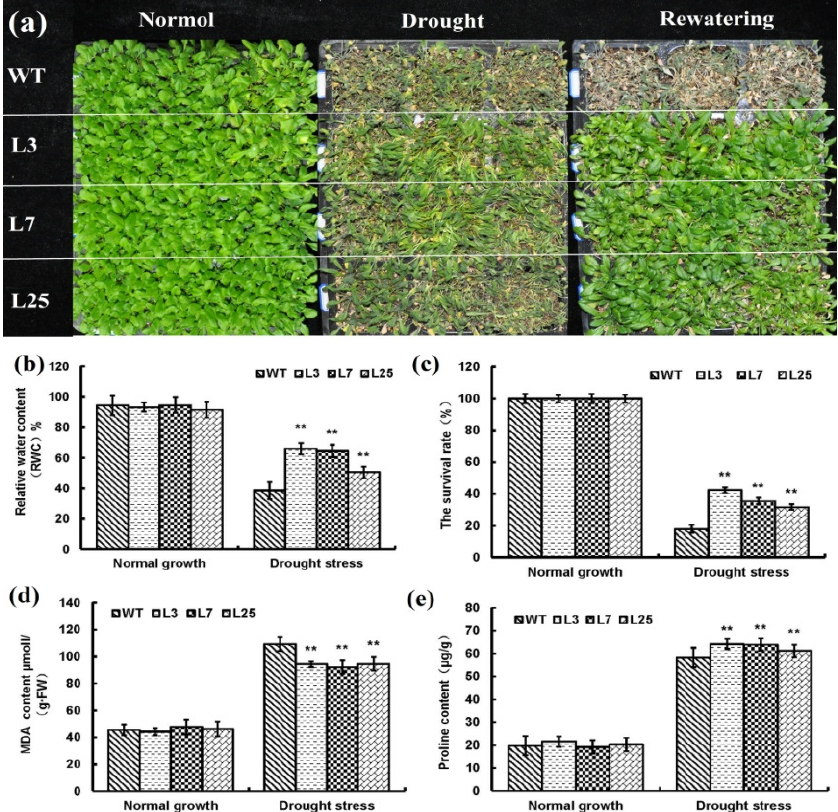
Figure 3. The morphological and physiological characteristics of transgenic lines (L3, L7 and L25) and wild-type Arabidopsis thaliana under drought stress were studied. ** indicate a significant difference at the 1% level. ( a ) Morphology and development under normal water condition, drought condition and after the restoration of watering of the plant were studied. ( b – e ) RWC, survival rate, MDA content and proline content were measured under normal water and drought stress.